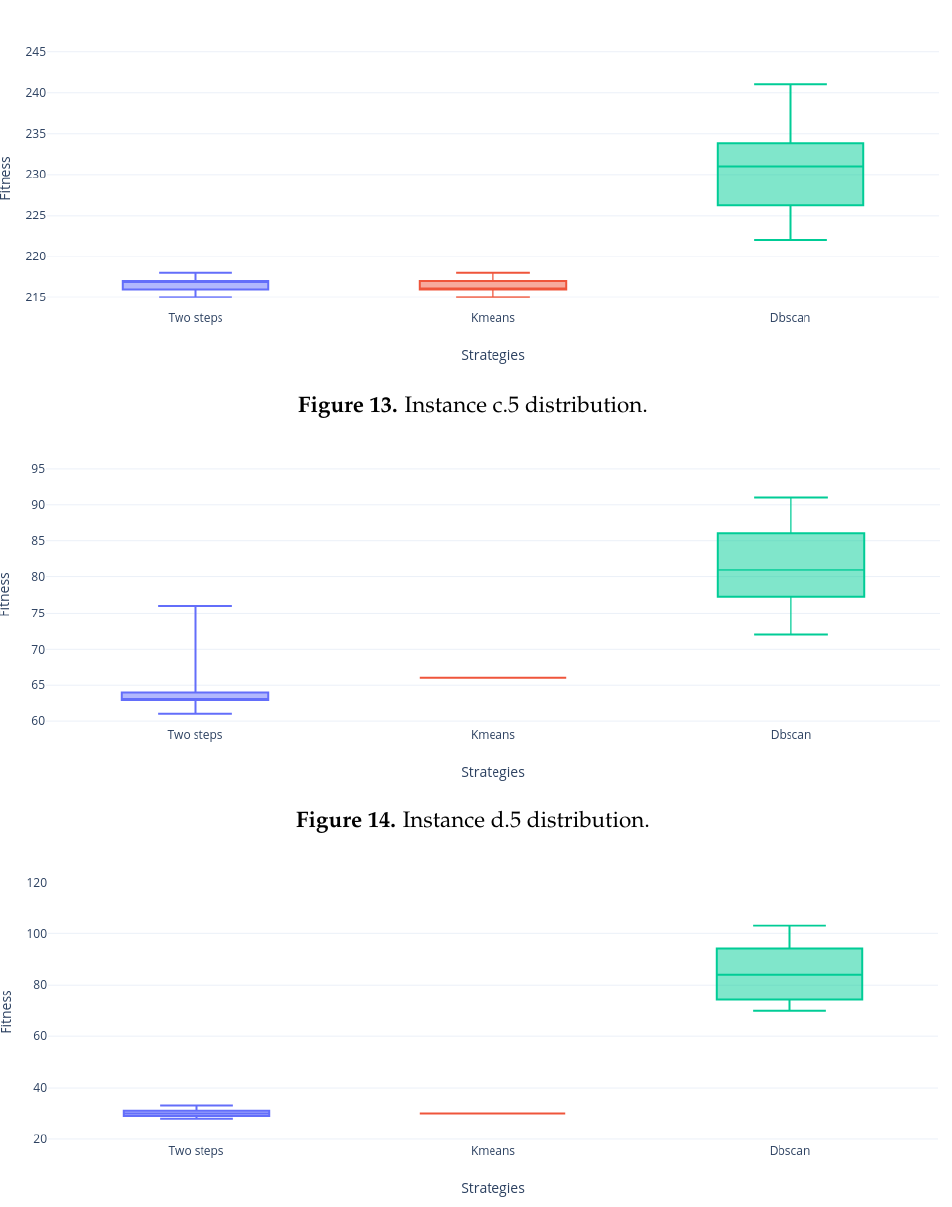
Figure 12. Instance b.5 distribution.